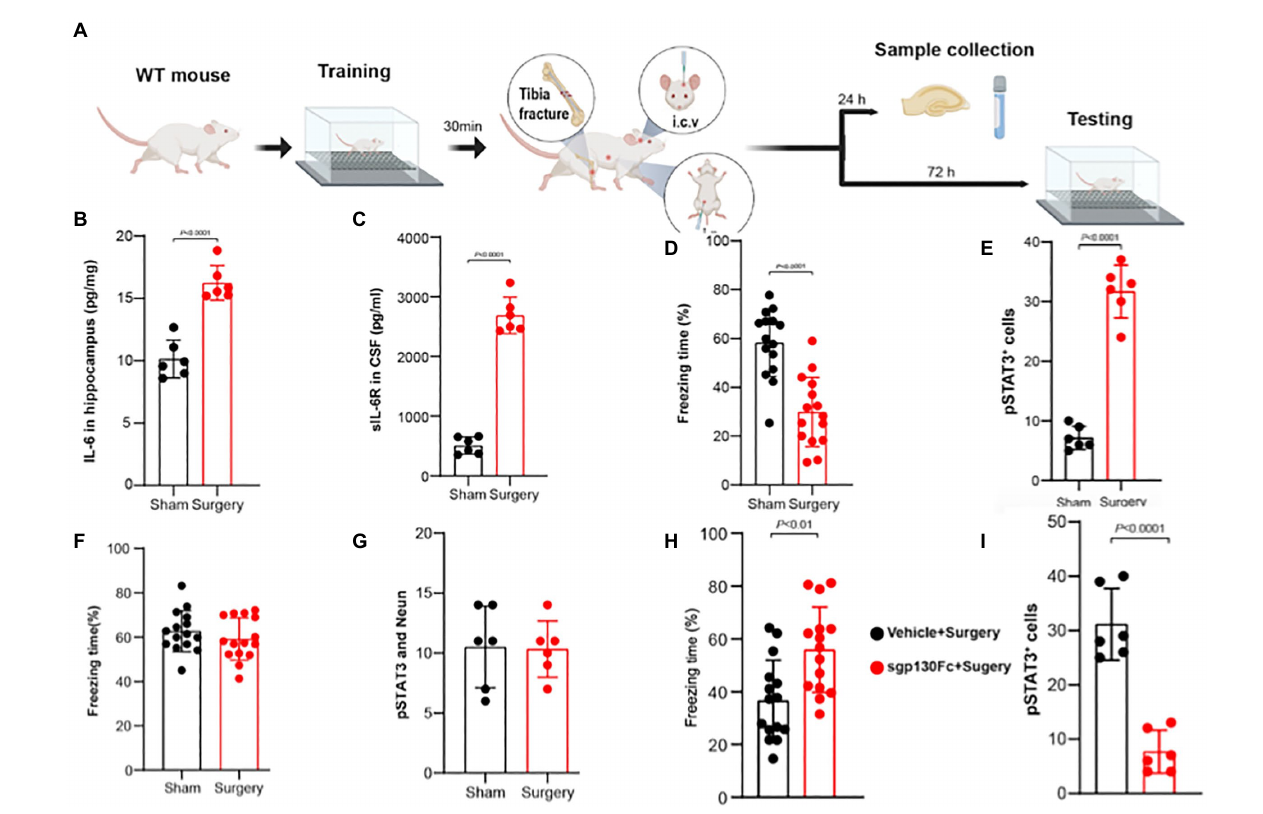
FIGURE 2 IL-6 trans-signaling in CA1 hippocampal neurons produces postoperative memory impairment. (A) Adult male mice underwent training for trace fear- conditioning (TFC) prior to tibia fracture surgery. At 24 h mice were killed and samples harvested; separate cohorts underwent testing in TFC at 72 h. Postoperatively, hippocampal IL-6 levels (B) and CSF sIL-6R levels (C) rise significantly. (D) Freezing time in the TFC declines significantly in the surgical group indicating postoperative memory impairment. (E) The number of pSTAT3 + neurons (counterstained with NeuN) increased significantly after surgery indicating upregulated IL-6 signaling. Following depletion of gp130 in the CA1 region of the hippocampus with direct injection of a viral vector containing a cassette to knockdown gp1`30 in excitatory neurons, surgery no longer decreases freezing time (F) nor increases the number of pSTAT3 + /Neun + cells (G) . Following administration of the selective IL-6 trans-signaling blocker, sgp130Fc, both postoperative freezing time (H) and the (I) number of pSTAT3 + neurons return to normal (Adapted from PMID: